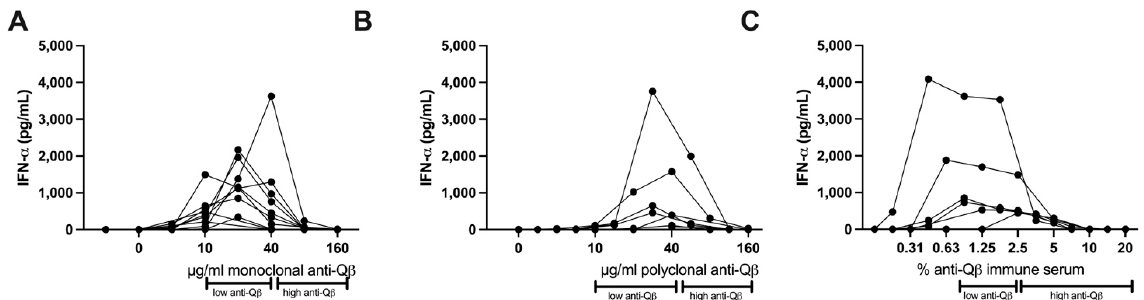
Figure 4. Dose of anti-Q β impacts on ability of vidutolimod to induce production of Type 1 Interferon by PBMCs. Unfractionated PBMCs were treated with vidutolimod plus various concentrations of monoclonal anti-Q β ( A ), polyclonal anti-Q β ( B ), or anti-Q β immune serum ( C ) and supernatant was tested for IFN α by ELISA. Statistical significance was determined using multiple paired T test with alpha = 0.05 comparing groups with high anti-Q β levels (>8 µ g or >2.5% immune serum), low anti-Q β levels (2–8 µ g or 0.88–2.5% immune serum), or no anti-Q β . For all three anti-Q β preparations, samples classified as having low anti-Q β levels had statistically greater production of IFN α than those with no anti-Q β or high levels of anti-Q β . Each curve represents a different PBMC donor. Graphs depict means +/ − SD ( n =